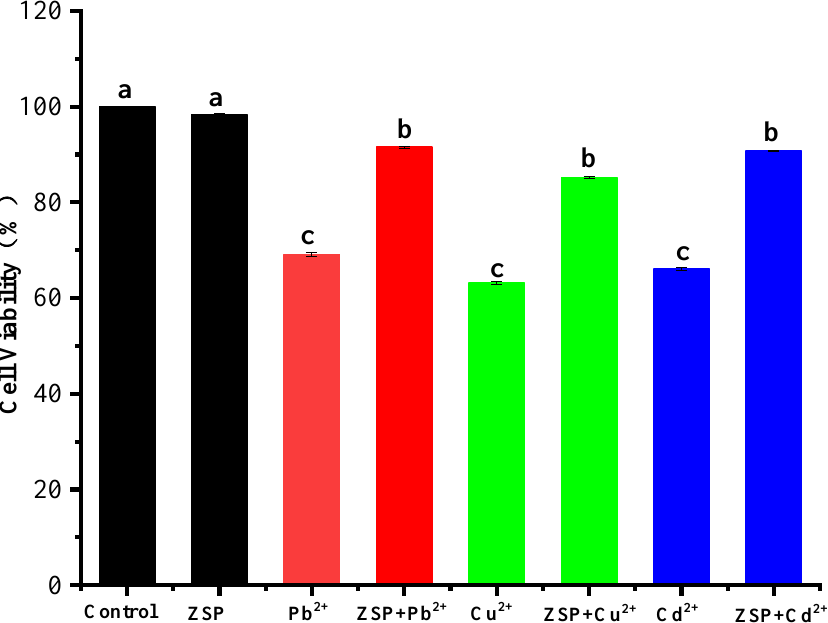
Figure 8. Preprotective effect of ZSP on cells treated with Pb 2+ , Cu 2+ and Cd 2+ . The cells were preprotected by ZSP polysaccharide for 12 h and treated with heavy metal ions for 12 h. Cell viability was measured by CKK-8 assay.(“a–c” means significant difference between different treatment groups; p <0.05.)